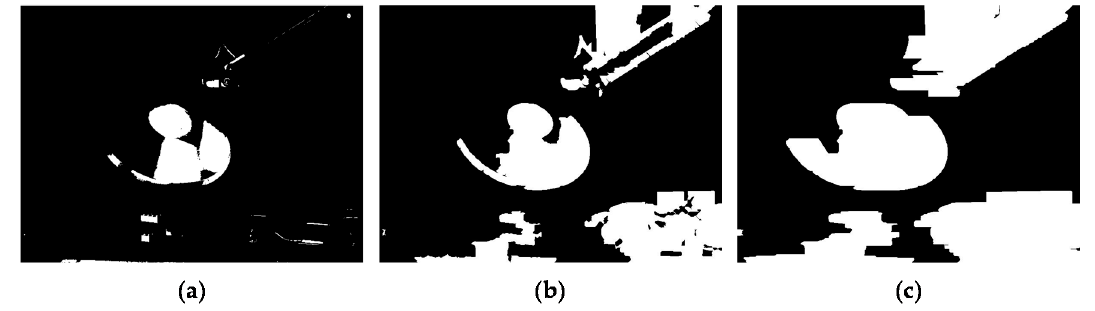
Figure 6. ( a ) Under/over-exposed region map, S ; ( b ) a set of all the segments that contain the under/over-exposed pixels; and ( c ) interest regions.